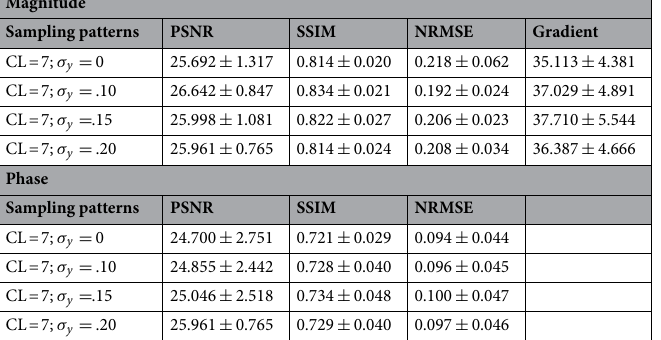
highly blurred images after FT with local aliasing-type of artifacts in both the background and the ROIs. The proposed model enhanced the edges sharpness and corrected the artifacts in the background, yet could neither recover the lost higher frequencies nor correct for the local artifacts inside the ROI (cf. red arrows in Fig. 4). Sampling pattern (b) led to blurred Fourier transformed images with subtle, local artifacts. Therefore, the model